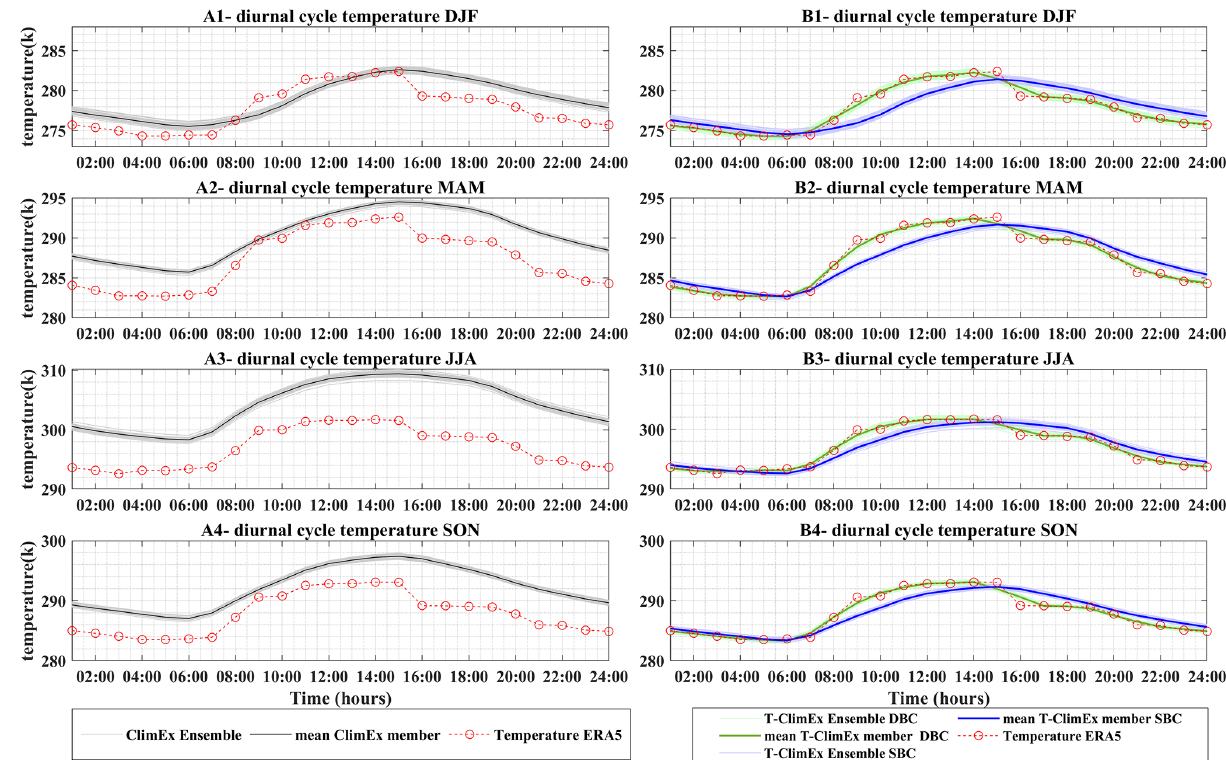
Figure 3. Annual diurnal cycle of temperature before bias correction (left column: A1 to A4) and after bias correction (right column: B1 to B4) for catchment 02143040. Each row corresponds to a different season: DJF (December, January, February), MAM (March, April, May), JJA (June, July, August), and SON (September, October, November). The right hand side shows both bias-correction methods: standard bias correction (SBC) and diurnal bias correction (DBC). The observations (ERA5) are shown in red. Raw (uncorrected) ClimEx data are in gray, SBC is in blue, and DBC is in green. The envelopes defined by all 50 ClimEx members are shown in the corresponding light colors, whereas the dark colored lines display the ensemble mean. Time shown is local time, with 24:00 corresponding to